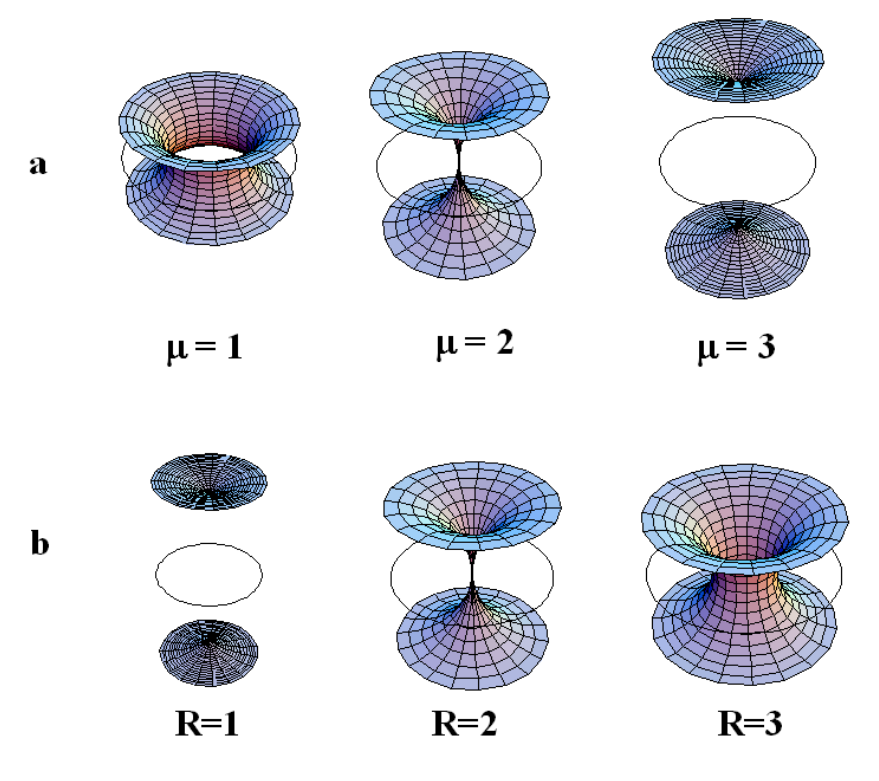
Figure 7. (a): torii with R = 2 for different increasing values of µ = 1 , 2 , 3 from the left to the right. When µ > R , two sheets exist: layer of type 3 takes place instead of type 2; (b): torii with µ = 2 for different increasing values of R = 1 , 2 , 3 from the left to the right. When R > µ , only one sheet exist: layer of type 2 takes place instead of type